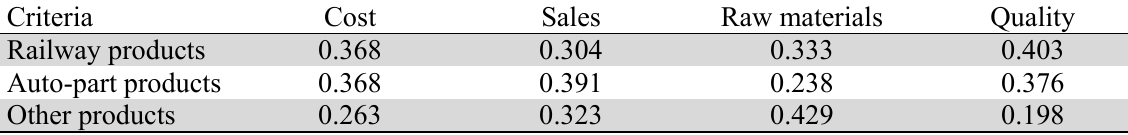
The results of pairwise comparison in section D